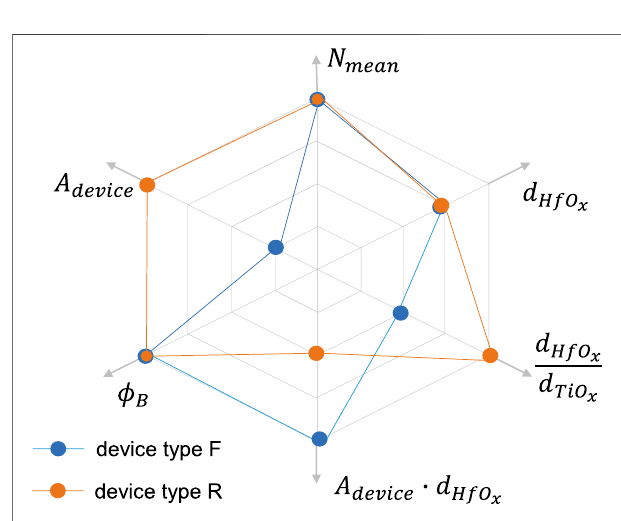
FIGURE 9 | Relevant technology and device parameters to realize a desired resistive switching behavior in the TiN/TiO x /HfO x /Au bi-layer memristive